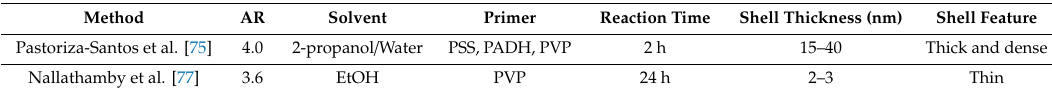
Table 2. Summary of the reaction conditions for silica coating on AuNRs using a surface primer with respective silica shell aspect. In both cases, the silica source is tetraethyl orthosilicate (TEOS) with no